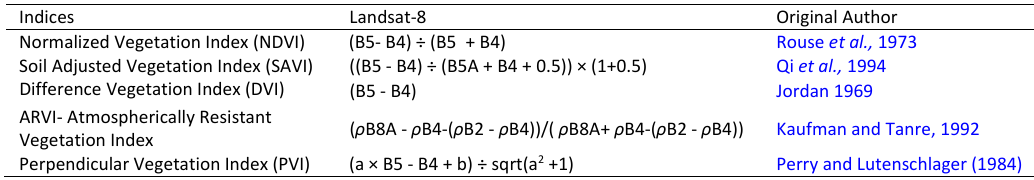
Table 1. Vegetation Indices for Landsat-8